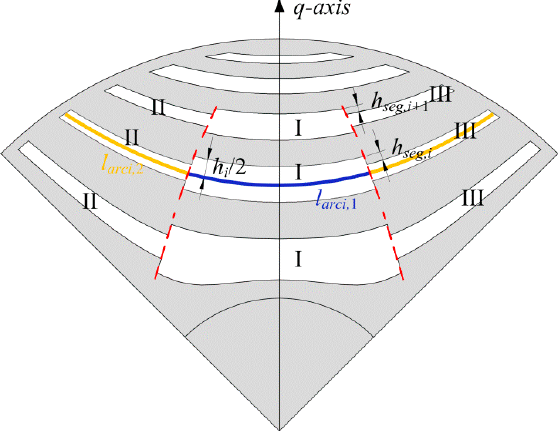
Figure 2. Proposed rotor structure and design variables.